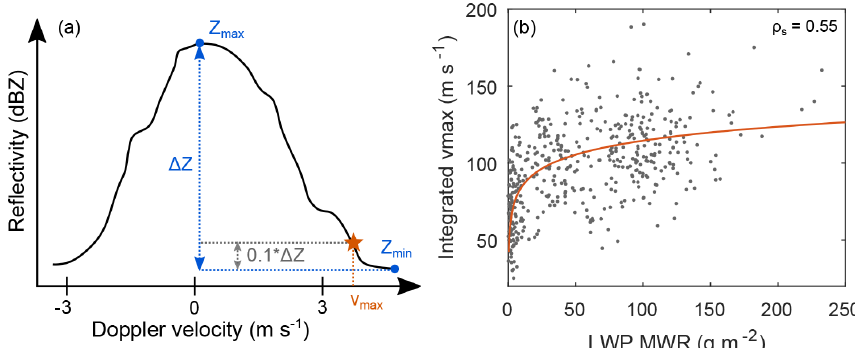
Figure A1. An example Doppler spectrum is shown in (a) to demonstrate the derivation of the maximum Doppler velocity v max (orange star), where Z min and Z max are the minimum and maximum radar reflectivities (see text for more details). The relationship between the vertically integrated v max and the LWP measured by the microwave radiometer for the time period 15:00–18:00UTC is shown in panel (b) . The orange line is a logarithmic fit through the data points, and ρ s indicates the Spearman’s rank correlation